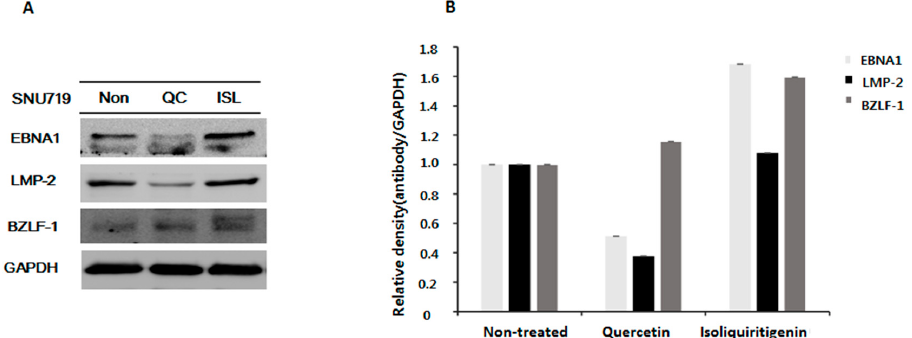
Figure 2. Expressions of EBNA1, LMP-2, and BZLF-1 proteins in tumor tissues from mice implanted with EBV(+) human gastric carcinoma (SNU719) EBV(+) human gastric carcinoma tumor tissue was excised from each animal fed quercetin (QC) or isoliquiritigenin (ISL) and prepared for western blot analysis. ( A ) The protein expression of EBNA1, LMP-2, and BZLF-1 were identified and ( B ) relative intensities were measured. GAPDH was used as the loading control.